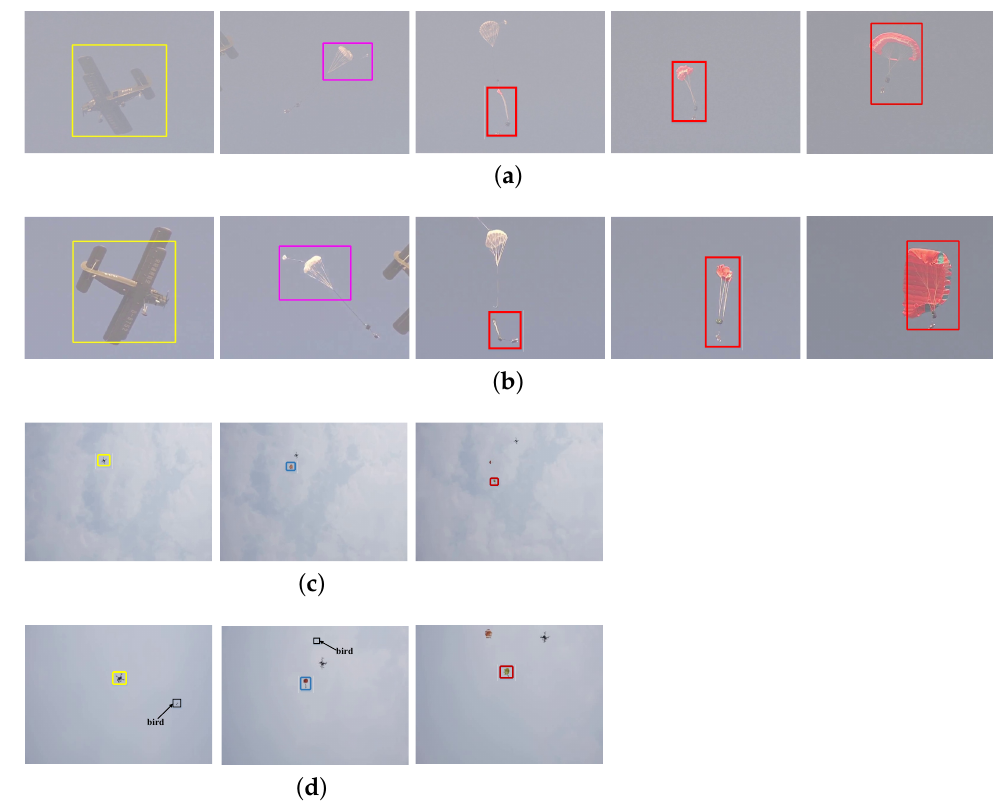
Figure 19. Multi-target tracking switch. ( a ) Video1 multi-target tracking switch, ( b ) Video2 multi- target tracking switch, ( c ) Video3 multi-target tracking switch, ( d ) Video4 multi-target tracking